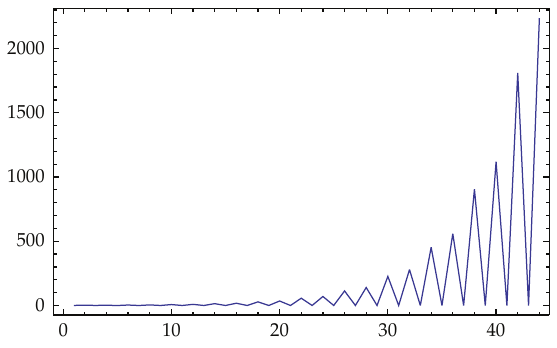
Figure 4: The di ff erence equation y n (cid:3) 1 (cid:4) 2 y n − 3 / (cid:5) 1 − y n y n − 2 (cid:6)